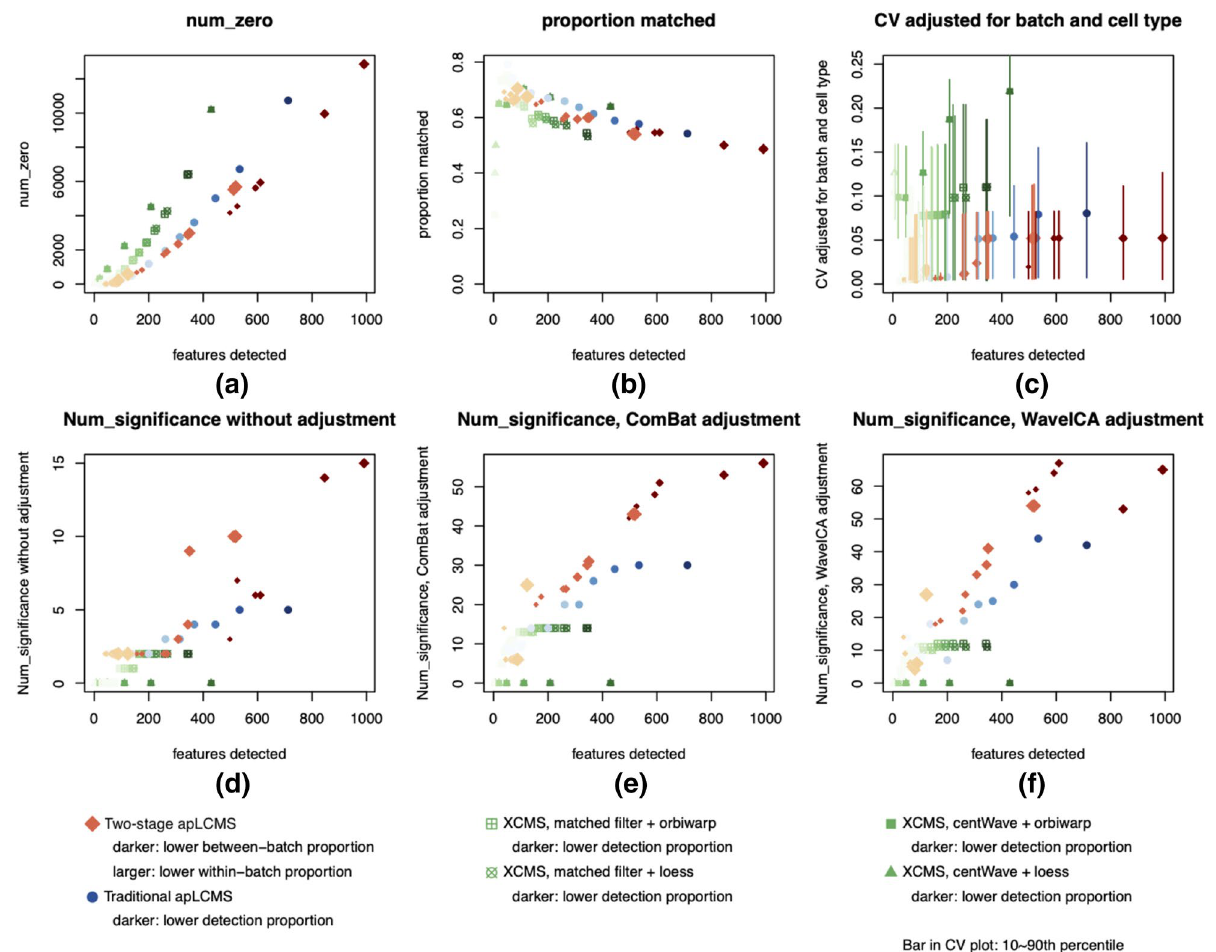
Figure 3. Comparison of the two-stage preprocessing approach with traditional apLCMS and XCMS using the ST000868 dataset. Each dot represents a parameter setting. ( a ) Proportion of zeros in the final data matrix before merging triplets for each subject; ( b ) Proportion of features with m/z matched to known metabolites by xMSAnnotator; ( c ) Within-triplet coefficient of variation (CV). Point is median; vertical bars represent 10th to 90th percentile. ( d ) Number of significant features at FDR ≤ 0.2, without batch effect correction; ( e ) Number of significant features at FDR ≤ 0.2, after batch effect correction by ComBat; ( f ) Number of significant features at FDR ≤ 0.2, after batch effect correction by